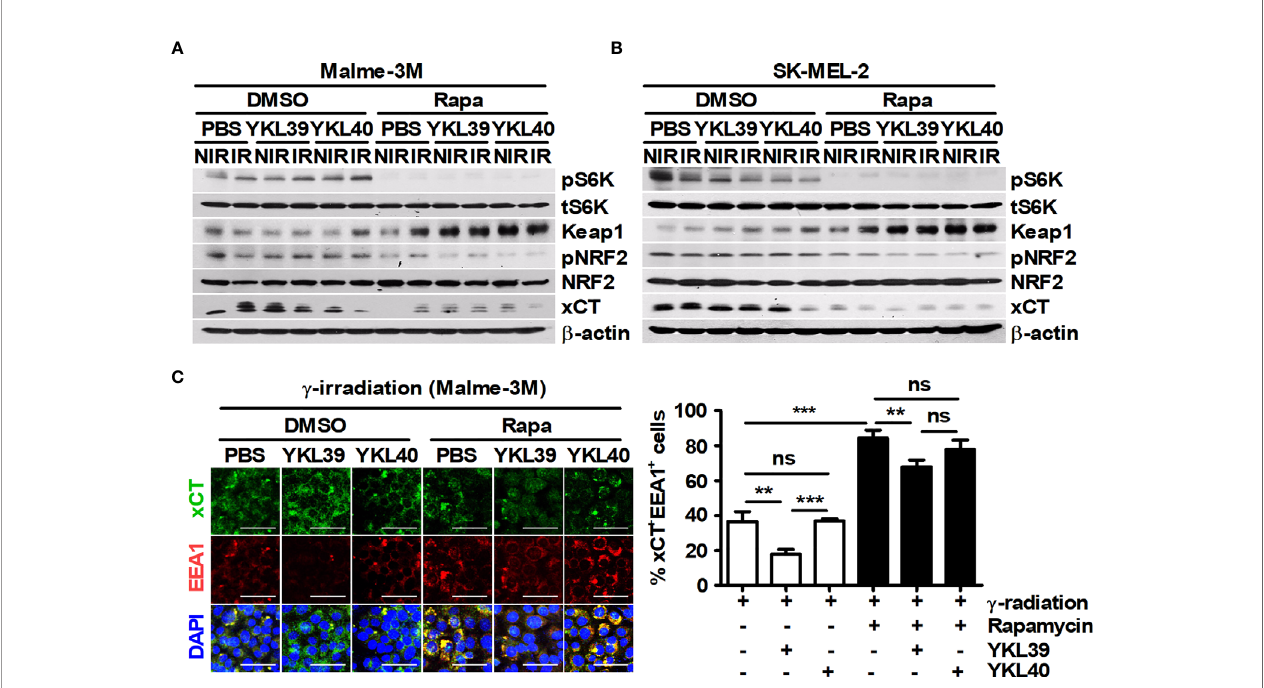
FIGURE 7 | Human YKL39 affects g -ray-induced colocalization of xCT and EEA1 in Malme-3M, a human melanoma cell line. (A – C) Malme-3M and SK-MEL-2 cells were treated with DMSO or 100 nM rapamycin for 3 h. After 3-Gy g -irradiation, each cell line was stimulated with recombinant human YKL39 and YKL40 for 21 h. (A, B) The expression levels of phospho-p70 S6K, p70 S6K, Keap1, phospho-NRF2, NRF, xCT, and b -actin in the cells were detected by western blotting. (C) Intracellular levels of xCT and EEA1 were assessed by confocal microscopy. Scale bars, 50 m m. The bars and error bars represent the mean ± SD; ** P < 0.01; *** P < 0.001; ns, not signi fi